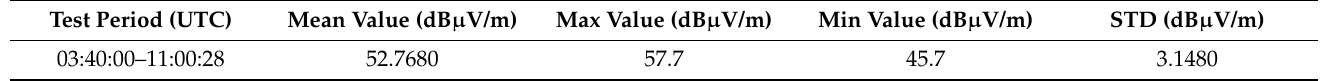
Table 5. Statistics of the low-frequency time-code signal on 23 June